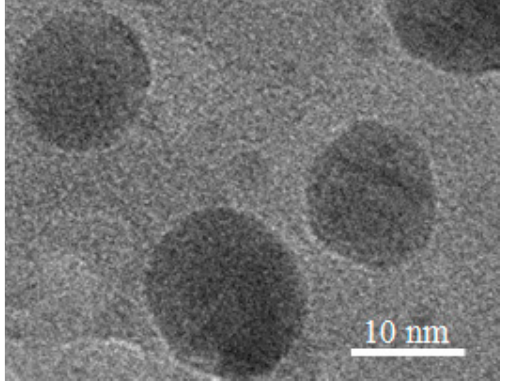
Figure 3. TEM images of NPs with sizes near 10 nm formed by ion-beam irradiation.